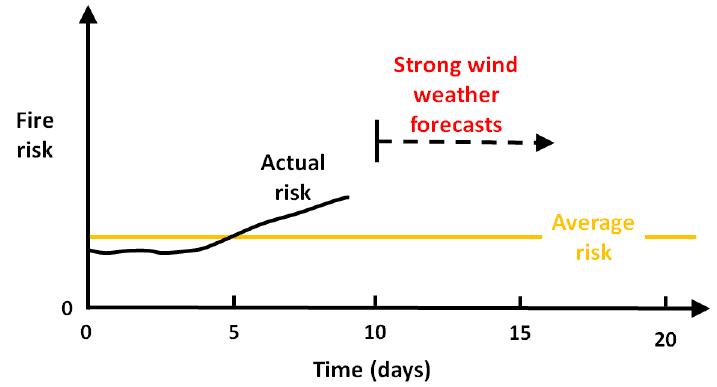
Figure 4. Sketch of indoor fire risk development at day 9 during a cold snap with adverse wind forecast for the next days.